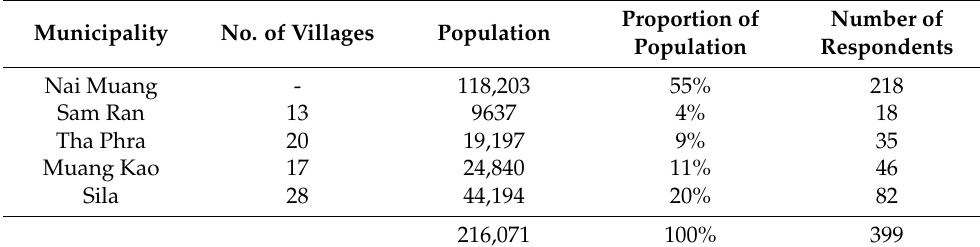
Table 2. Sample size for the